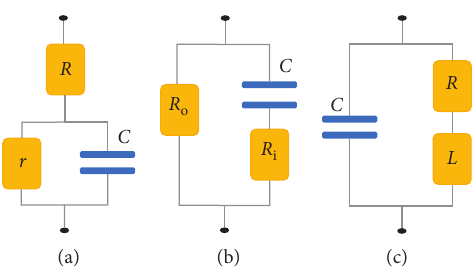
Figure 1: Equivalent circuits proposed by (a) Philippson, (b) Fricke and Morse, and (c) Cole and Baker.